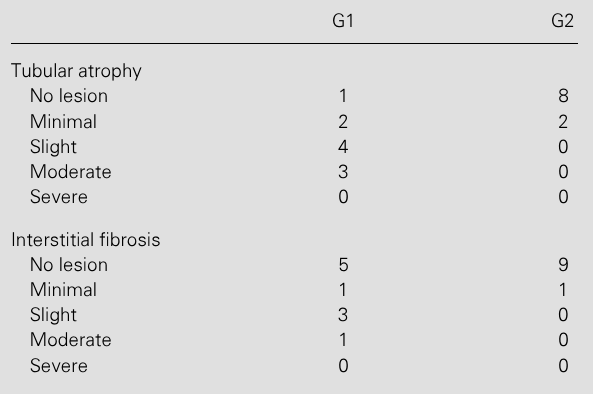
Table 3 - Tubular atrophy and interstitial fibrosis in kidney biopsies from patients with glycosuria (G1; N = 10) and without glycosuria (G2; N =